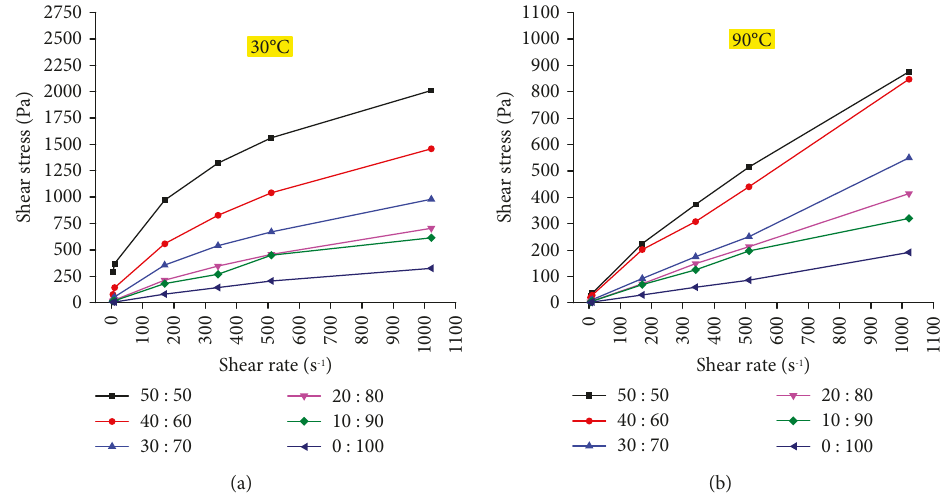
Figure 5: The relationship between shear strength and shear rate at di ff erent